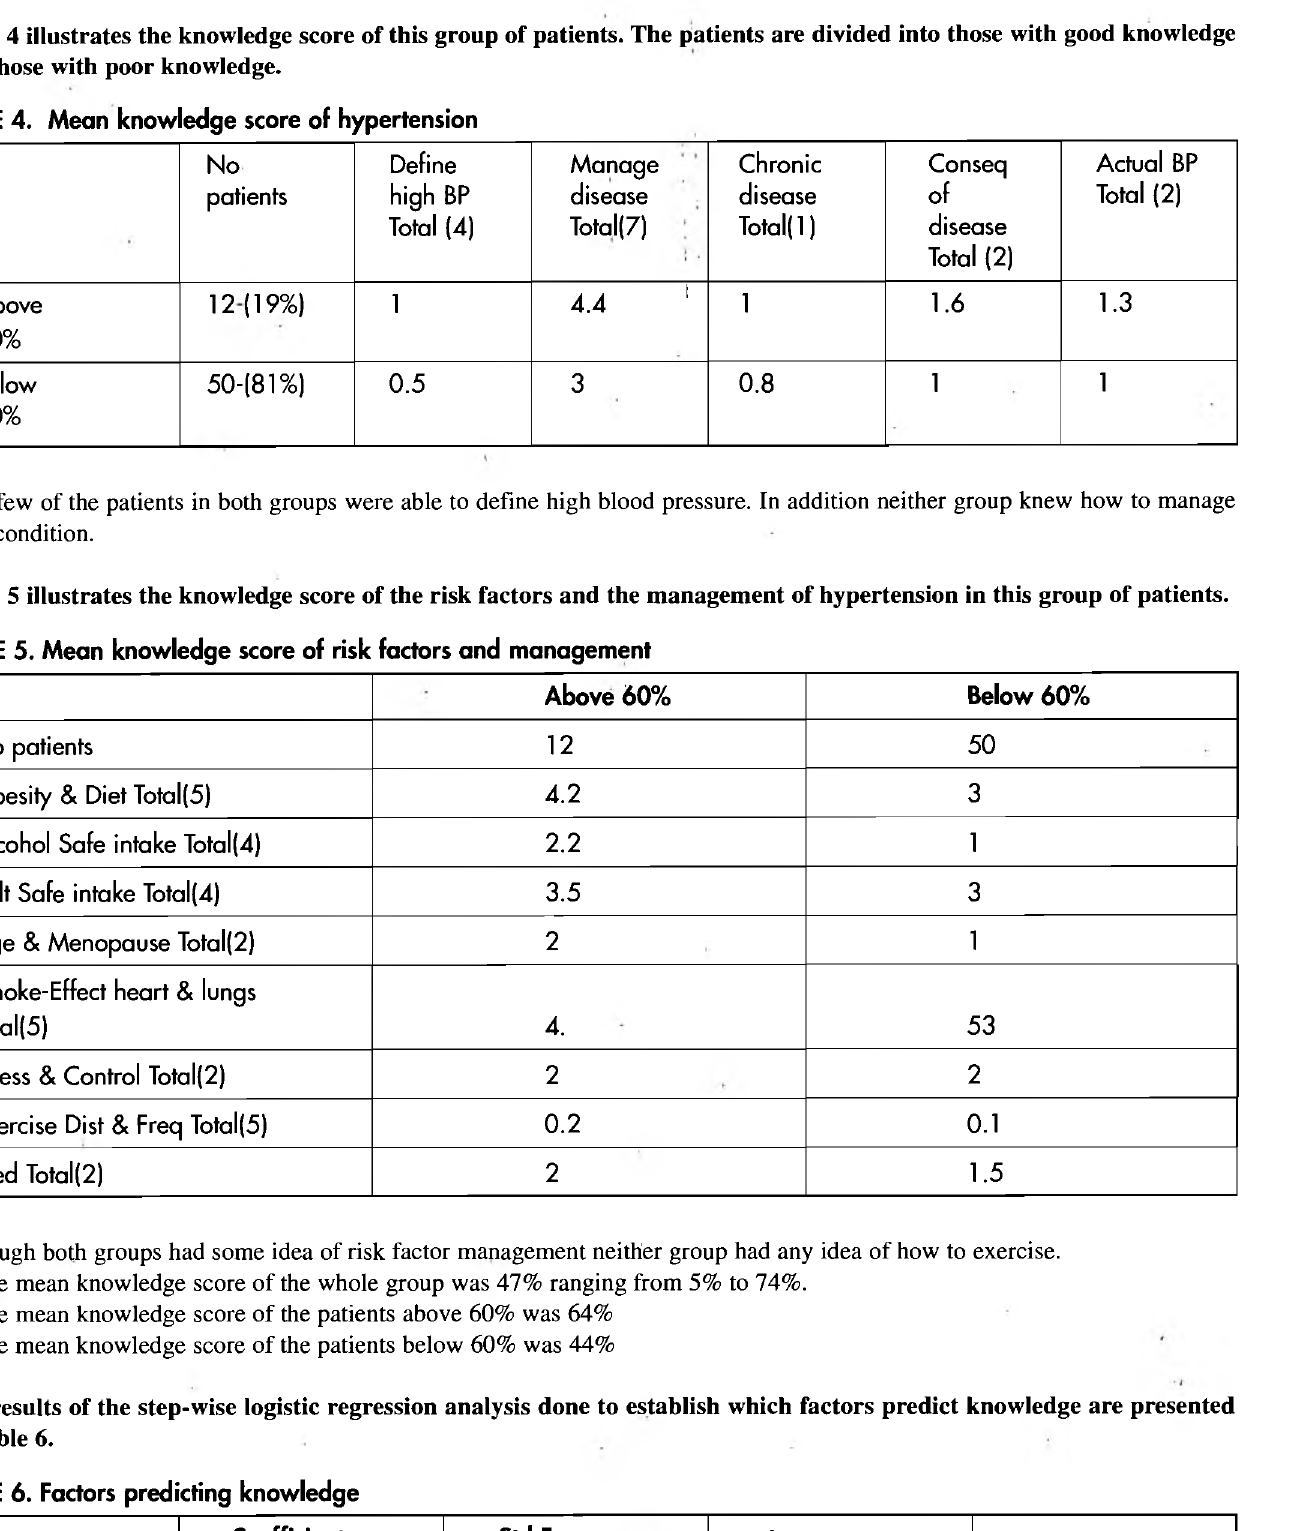
TABLE 6. Factors predicting